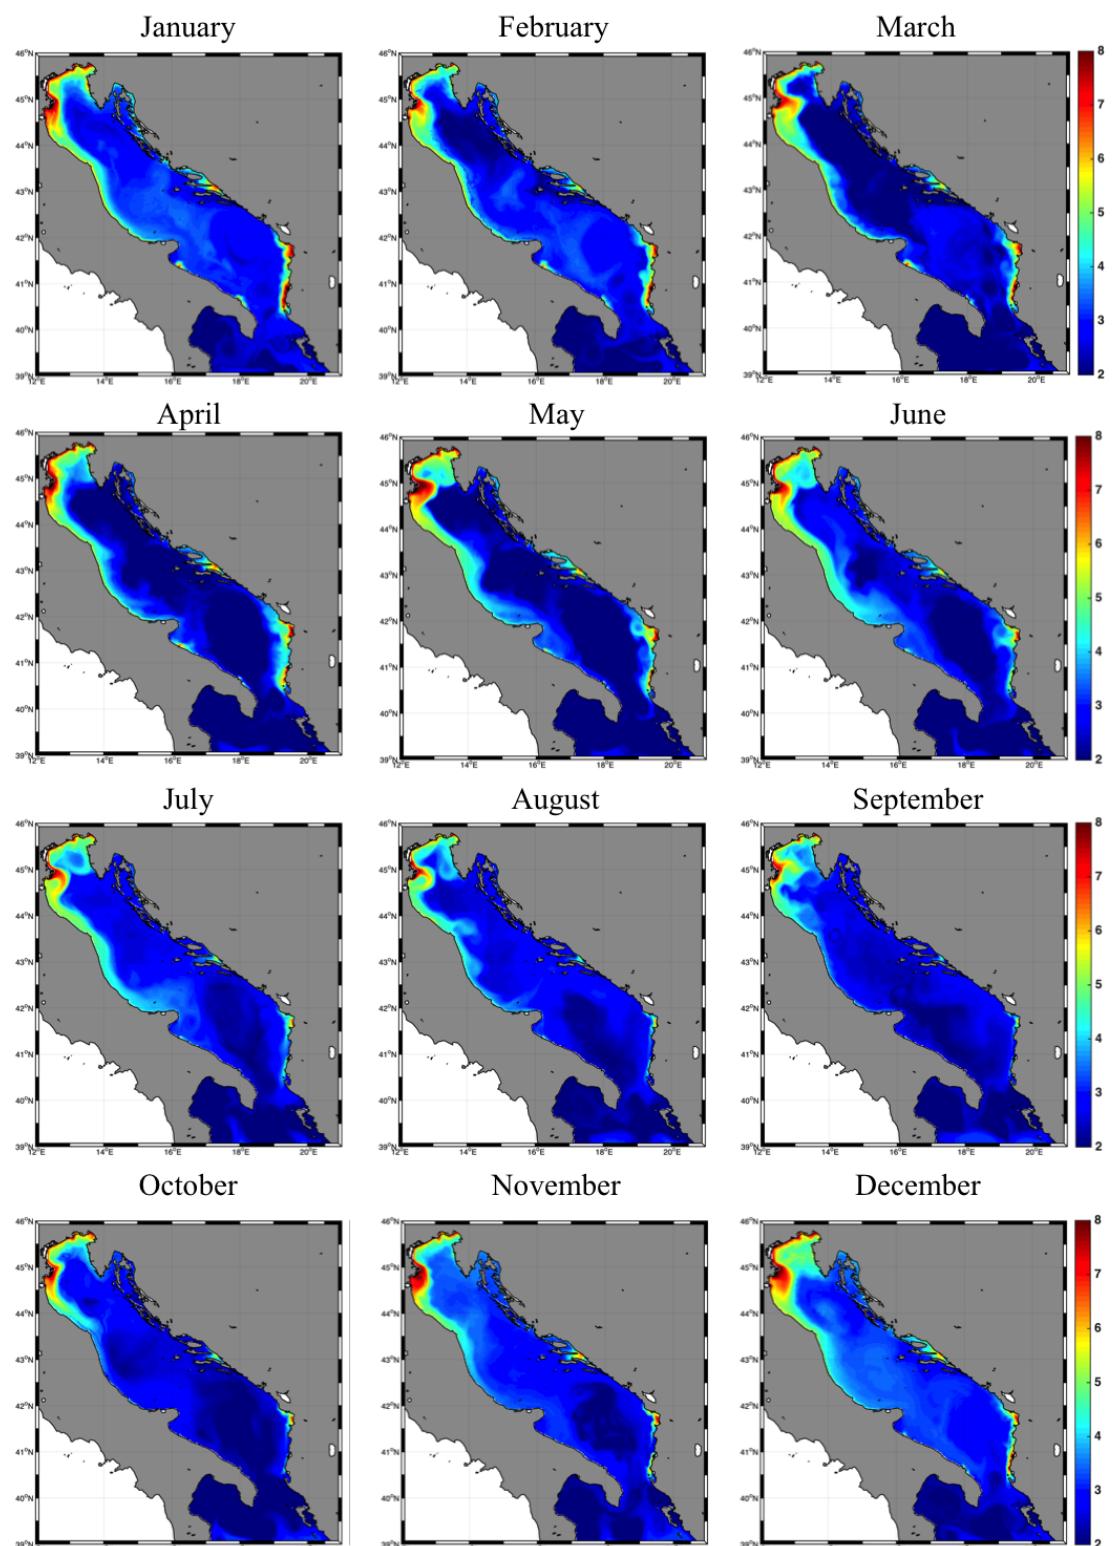
Figure 8. Monthly averages of the model TRIX for the Adriatic and upper Ionian